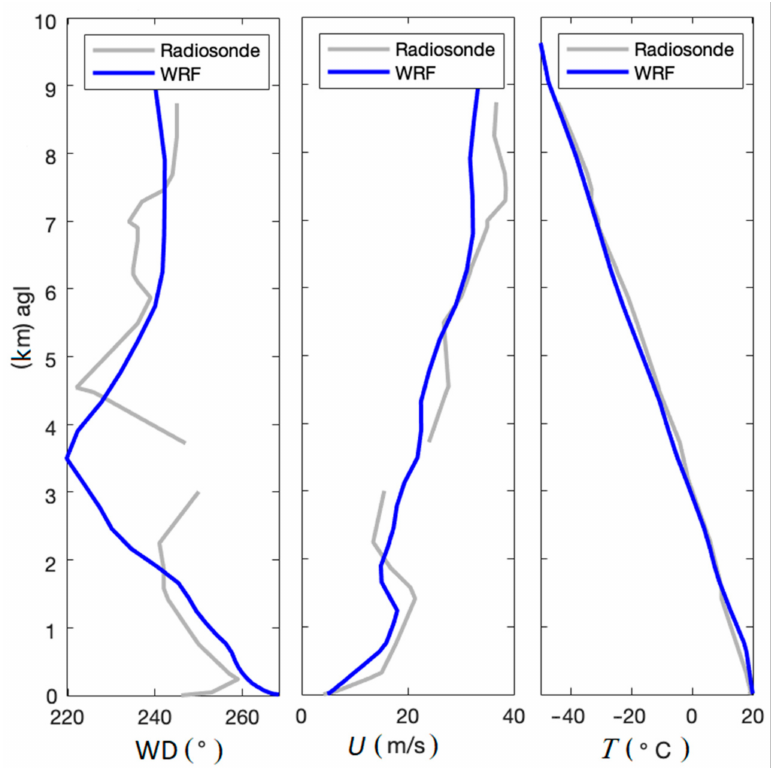
Figure 6. Vertical profiles comparing WRF WD , U , and T to a National Weather Service (NWS) radiosonde launch on 17 April 2028 at 1200 UTC from Santa Teresa, NM, NWS site